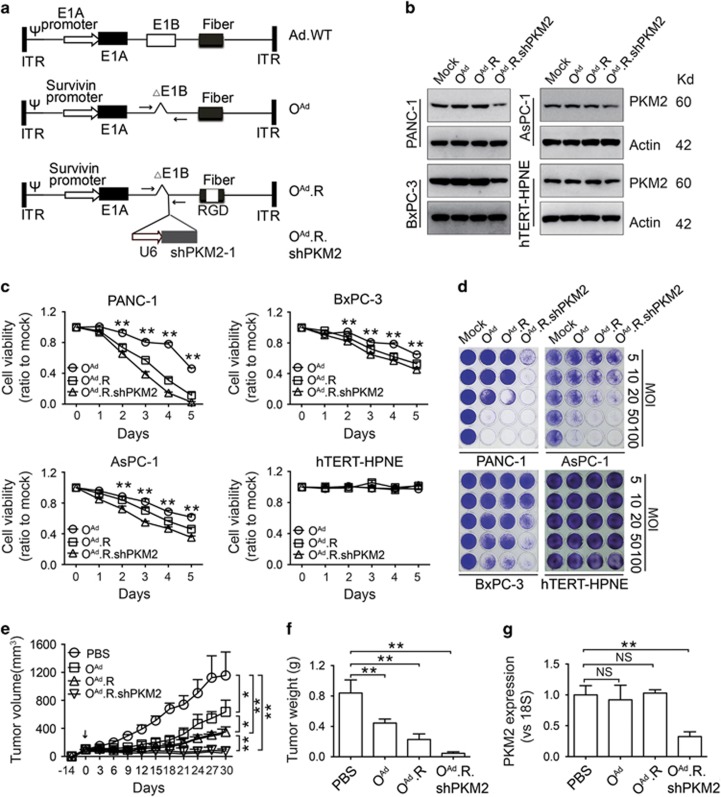
RGD-modified oncolytic adenovirus carrying shPKM2 exerts an enhanced cytotoxic effect in pancreatic cancer cells. (a) Schematic construction of the oncolytic adenoviruses. Arrows indicate the primers used to detect wild-type adenovirus contamination. (b) PKM2 expression was detected in cells infected with the indicated oncolytic adenovirus for 2 days at an MOI of 10. (c) The viability of cells infected with the indicated oncolytic adenoviruses at an MOI of 10 was assessed using CCK-8 assays. (d) The viability of cells infected with OAd.R.shPKM2 at the indicated MOIs for 5 days was measured using crystal violet staining. (e) The growth curve of PANC-1 xenograft tumors after intratumoral injection of the indicated adenoviruses. Arrows represent the action of the intratumoral injection. (f) Tumors were excised and weighed 30 days after initial injection. (g) qRT-PCR detection of PKM2 expression in tumors. The data were normalized to 18S levels and are shown as the fold change relative to PANC-1 shCtrl cells. All experiments were repeated three times, and the bars represent the mean±S.D. (n=3 in c, n=6 in e–g), *P<0.05, **P<0.01. NS, no significance